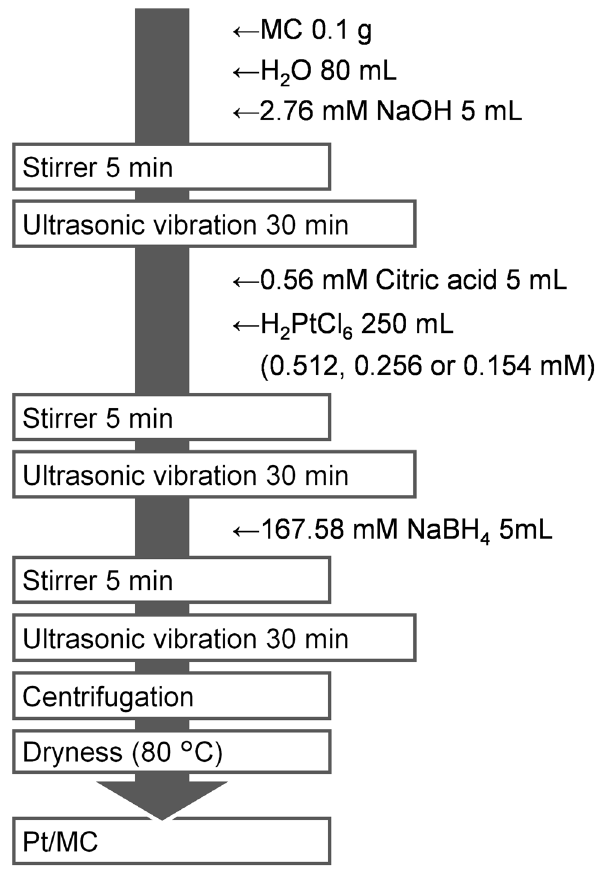
Fig. 3 Preparation flow of the MC-supported Pt catalyst